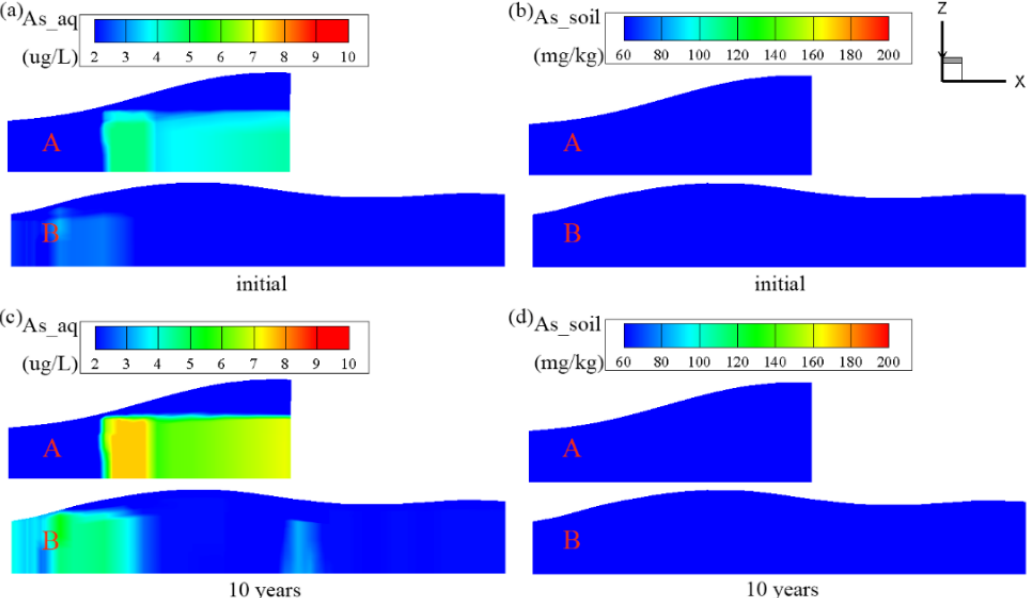
Figure 6. Initial distributions of As concentration in groundwater ( a ) and in soil ( b ), The simulated distributions of As concentrations in groundwater ( c ) and in soil ( d ) after 10 years of the complete ex- cavation of highly contaminated soil (scenario 3). Here, As_aq and As_soil represented groundwater arsenic concentration, soil arsenic concentration,